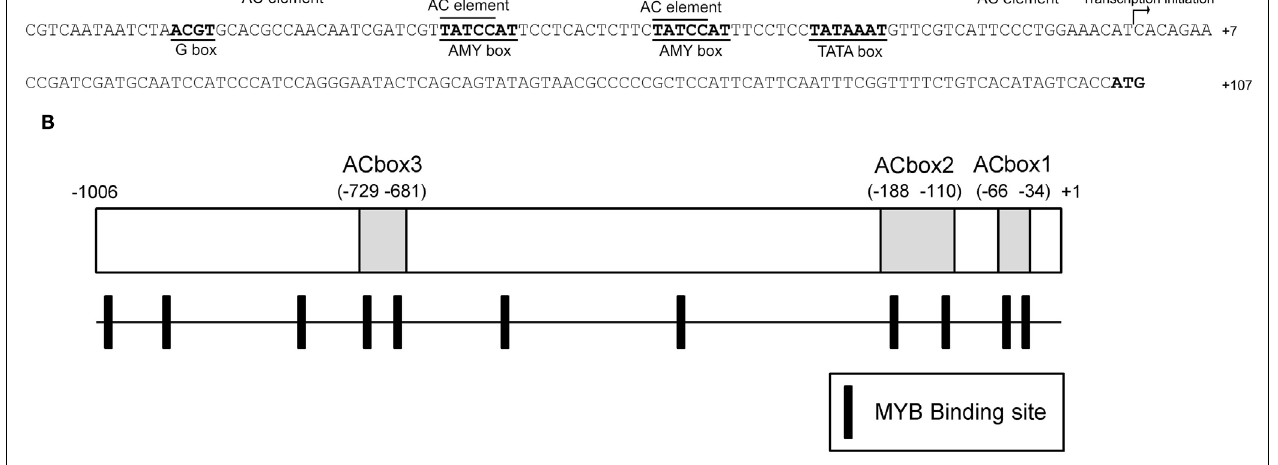
transcription initiation site ( + 1) determined by RLM-RACE PCR. (B) A schematic representation of the distribution of AC elements in the PpAS1 gene promoter.The positions of ACBox1, ACBox2, and ACBox3 are marked.